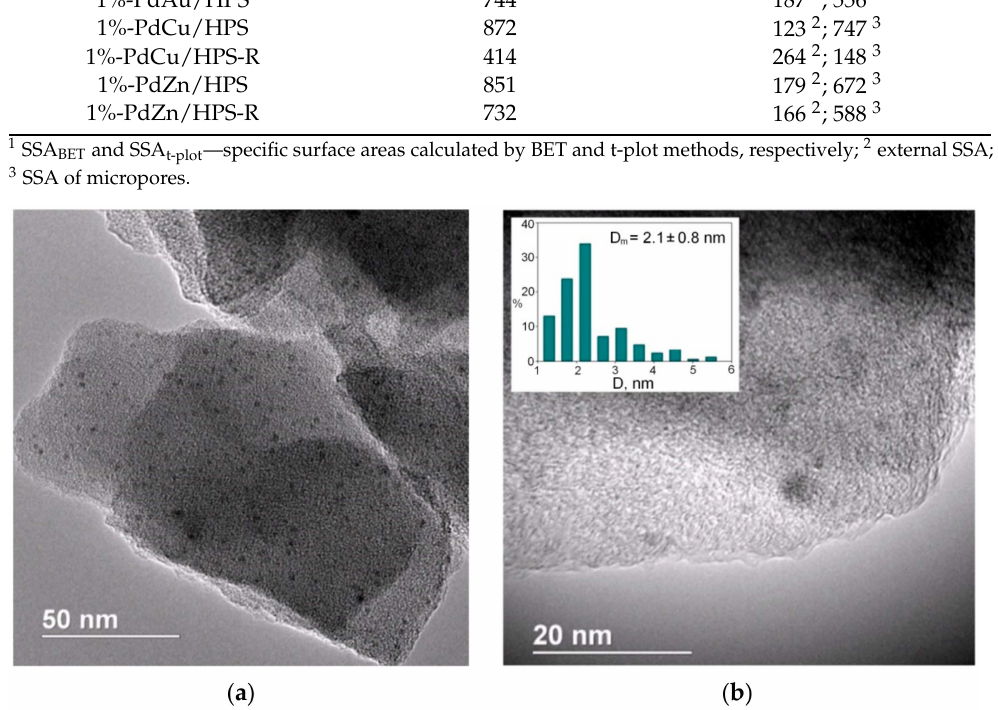
Figure 1. Bright-field STEM images of the reduced sample 1%-Pd/HPS-R at different magnification: scale 50 nm ( a ) and scale 20 nm ( b ).